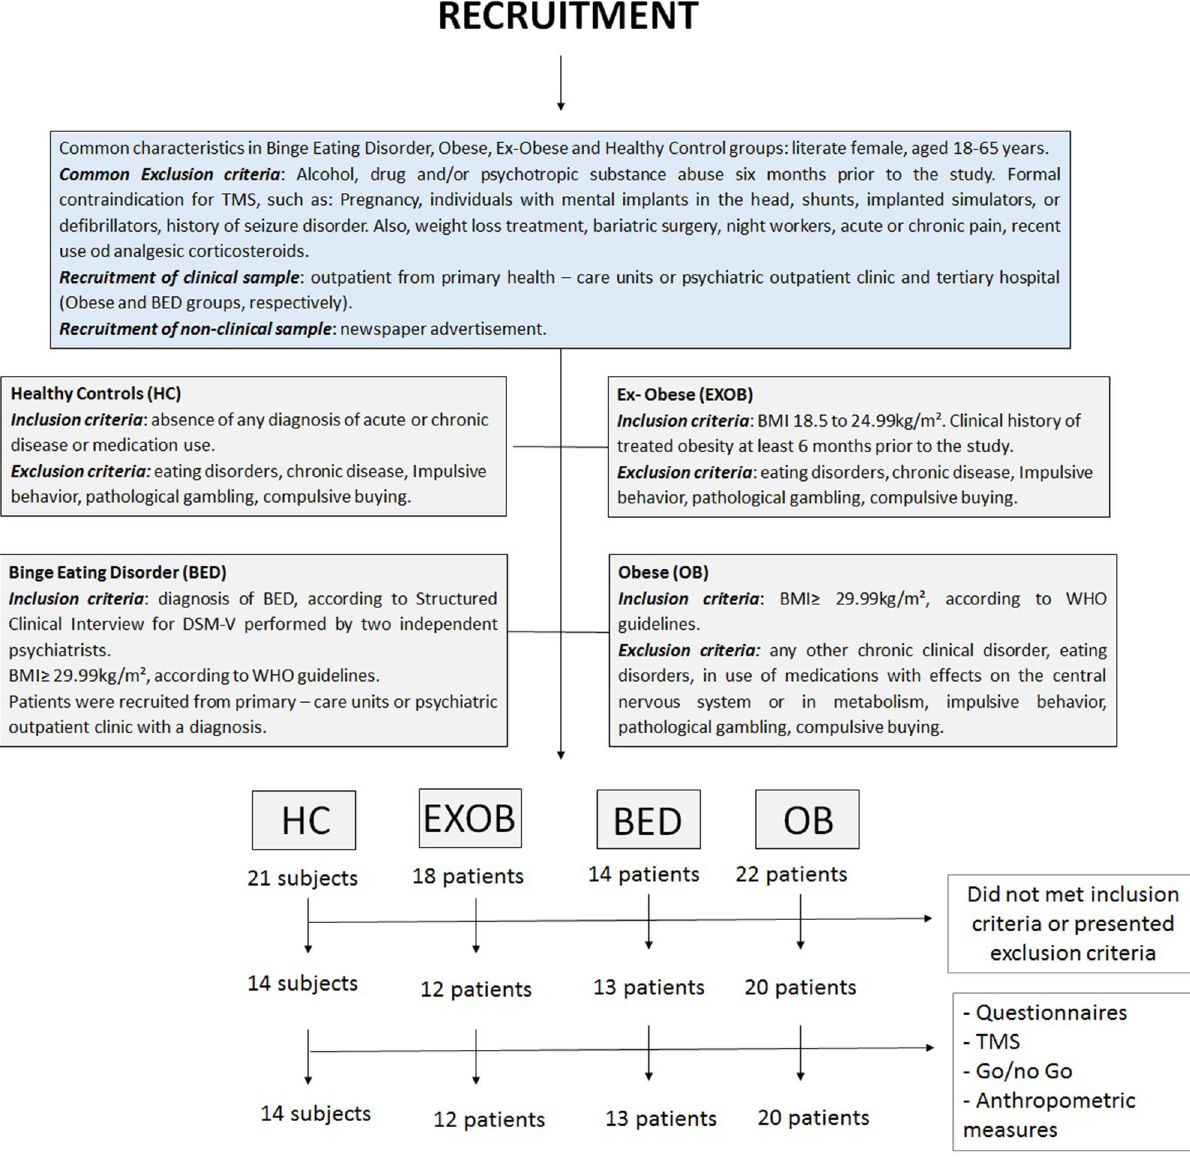
FIGURE 1 | Flow of the